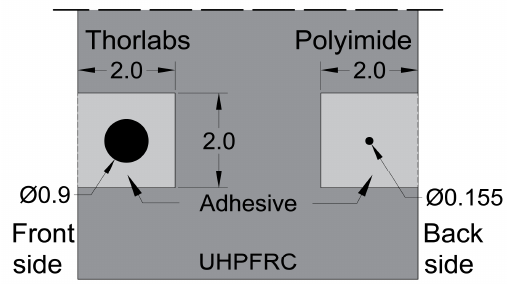
Figure 6. Scheme of installation method of DFO sensors in UHPFRC; dimensions in mm.